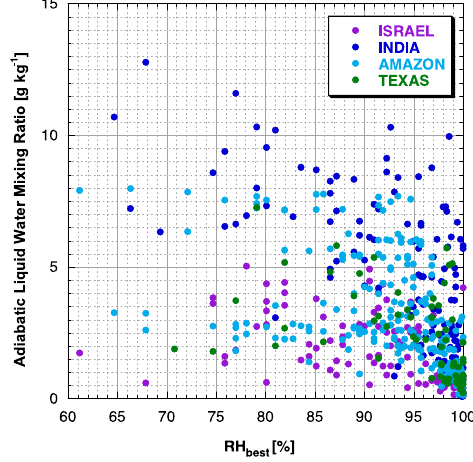
Fig. 7. Each data point represents RH best that was calculated for one cloud pass (and based on the derived N a of each profile) vs. LWC a , which relates to the vertical dimension. The same color-coding as in Fig. 5 is used with the addition of data from the Large- Scale Biosphere-Atmosphere Experiment in Amazonia – Smoke, Aerosols, Clouds, Rainfall, and Climate (SMOCC; Andreae et al., 2004) in cyan. It appears like the highest RH best values are found near cloud base, indicating strong tendency towards extreme inho- mogeneous mixing, maybe due to the small droplets and fairly weak turbulence